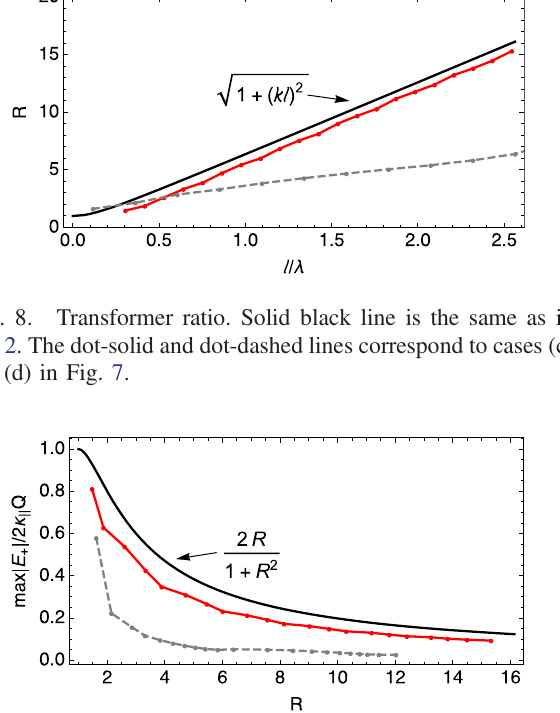
FIG. 9. The normalized maximum accelerating field as a function of the transformer ratio. The solid black line is the same as in Fig. 2. The dot-solid and dot-dashed lines correspond to cases (c) and (d) in Fig.